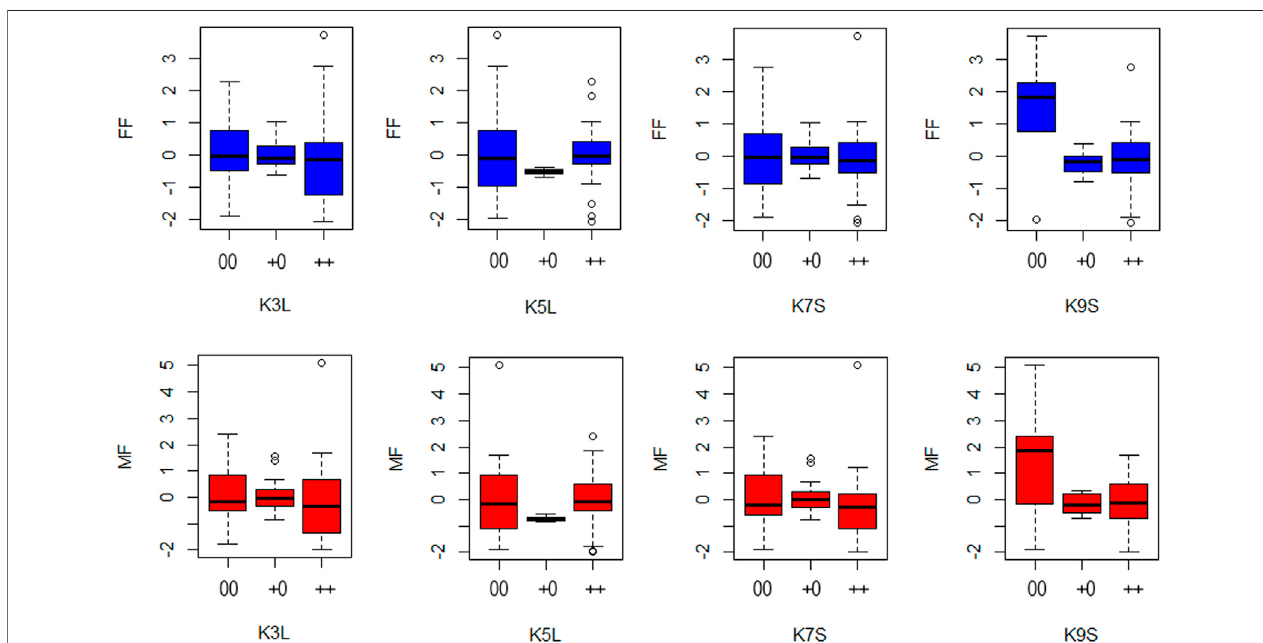
FIGURE 7 | Boxplots show male (MF) and female (FF) fl owering time for each knob condition in the K3L, K5L, K7S, and K9S positions, considering both allele substitution and dominance effects. The x -axis shows the classi fi cation for each knob condition 00 (cid:1) knob absence; +0 (cid:1) heterozygous knob presence and ++ (cid:1) homozygous knob presence. The y -axis shows the genetic effects of fl owering time for female and males